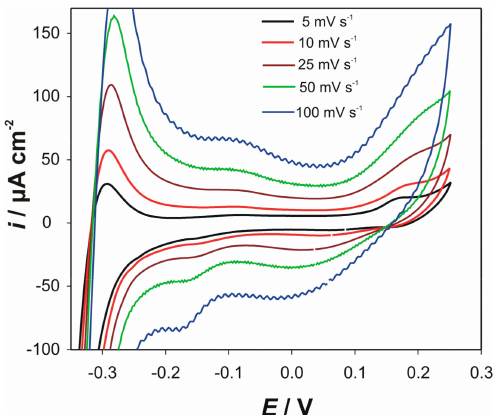
Figure 6. CVs of the electrode “ACS” in the presence of 1 × 10 − 4 M cysteine at various scan rates. Measurements were performed in 90 mL 0.1 KNO 3 + 10 mL 0.1 M acetate buffer pH